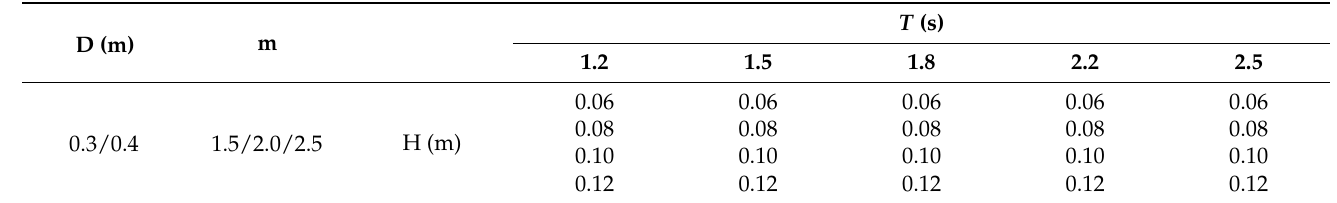
Table 1. Physical experiment wave parameters, where m is slope, D is water depth, H is wave height, and T is period.